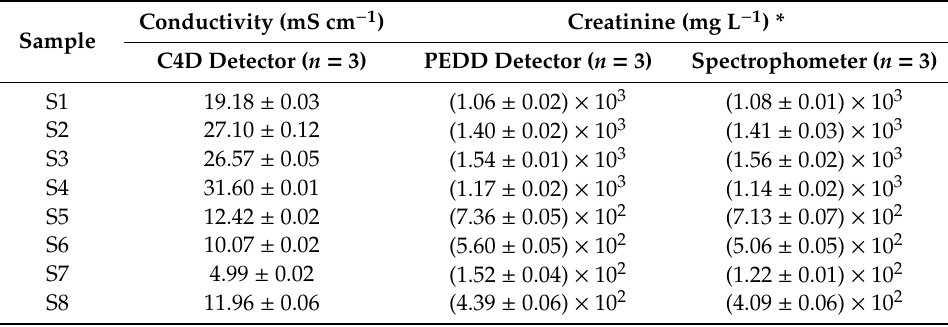
Table 1. Analysis of conductivity and creatinine of human urine